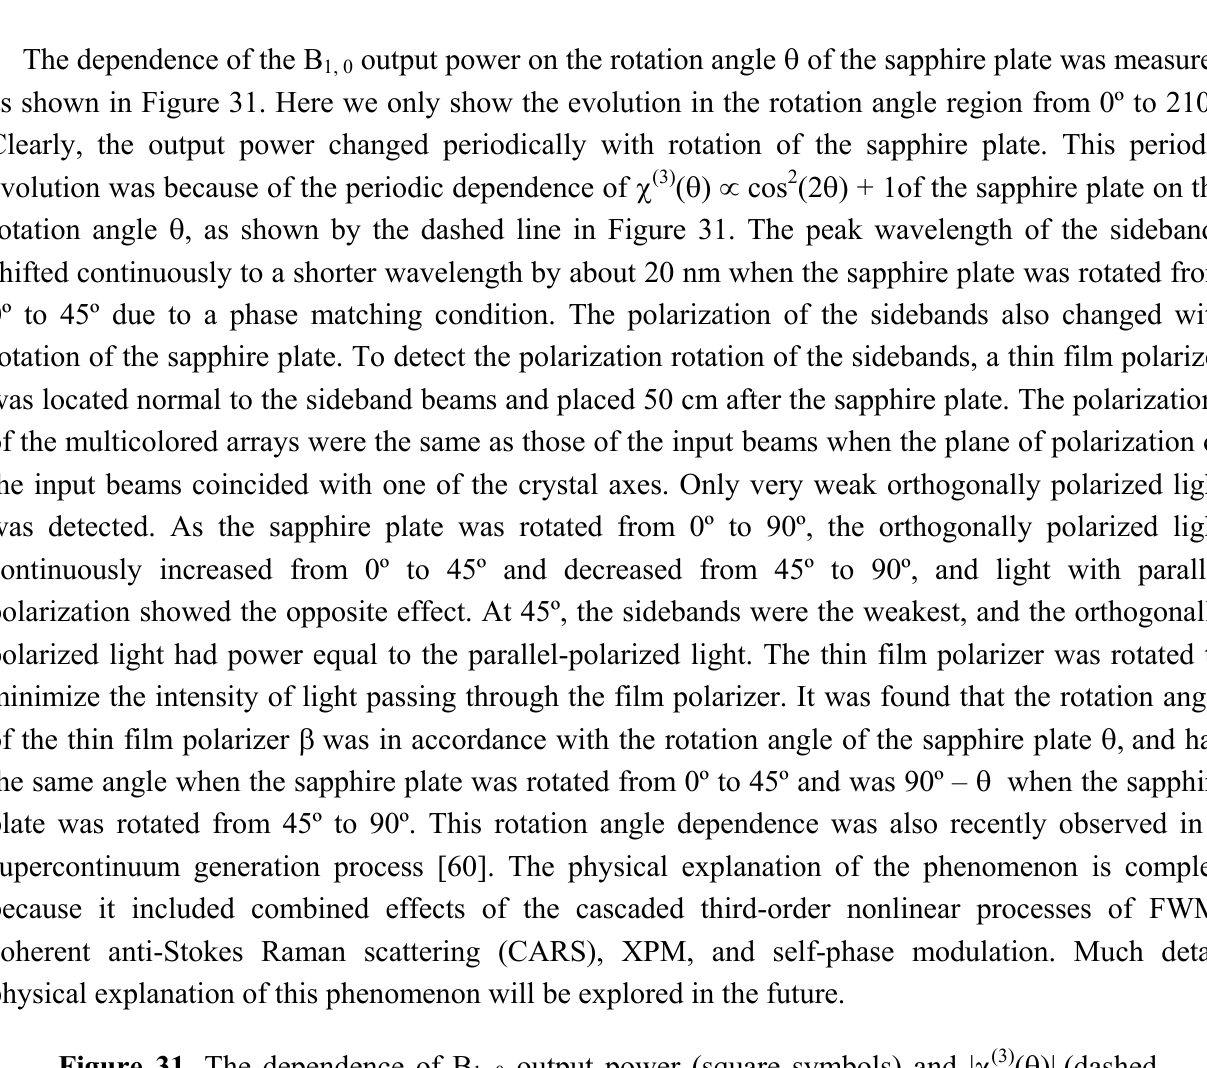
output power (square symbols) and | χ (3) (θ)| (dashed Figure 31. The dependence of B 1, 0 line)of the sapphire plate on the rotation angle θ of the sapphire plate